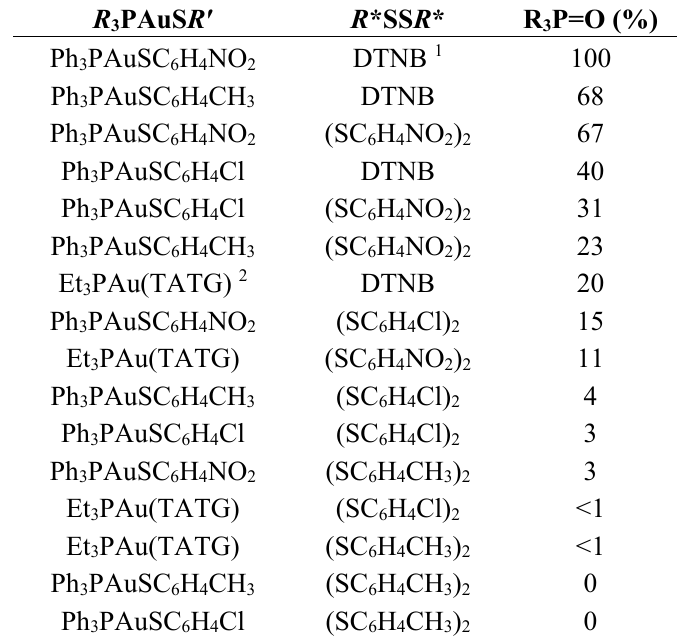
Table 1. Comparison of the percentage of R 3 P=O formed from the reaction of 10 mM P R 3 AuS R ʹ and 10 mM R *SS R * in DMSO- d 6 ( t = 75